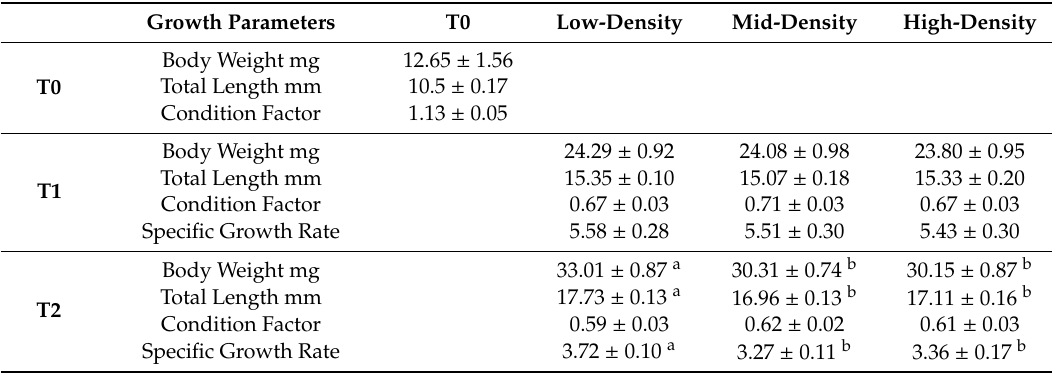
Table 3. Growth performance of Siberian sturgeon larvae reared at di ff erent densities in the time-points T0, T1, and